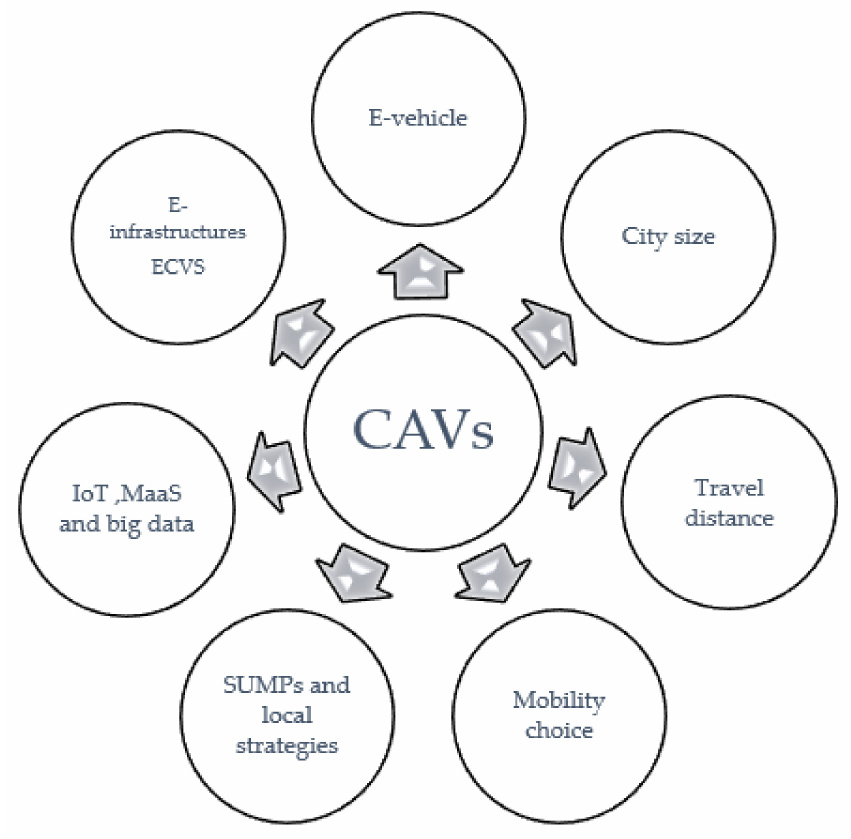
Figure 10. Proposal future works